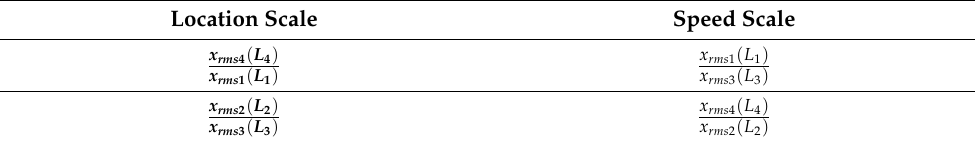
Table 4. Equations for calculating sensor location and rod speed scaling factors.